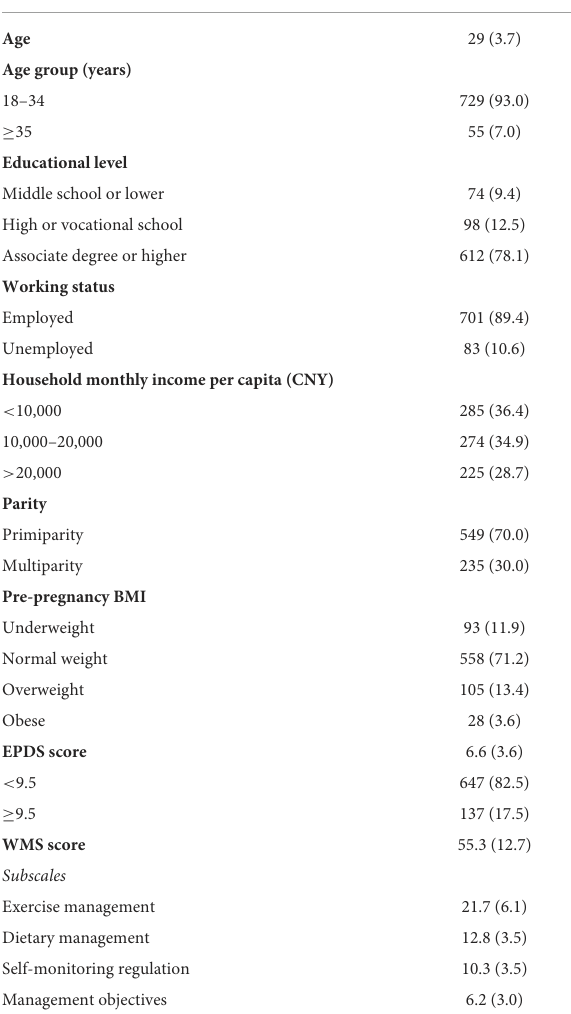
TABLE 1 Characteristics of participants ( N =